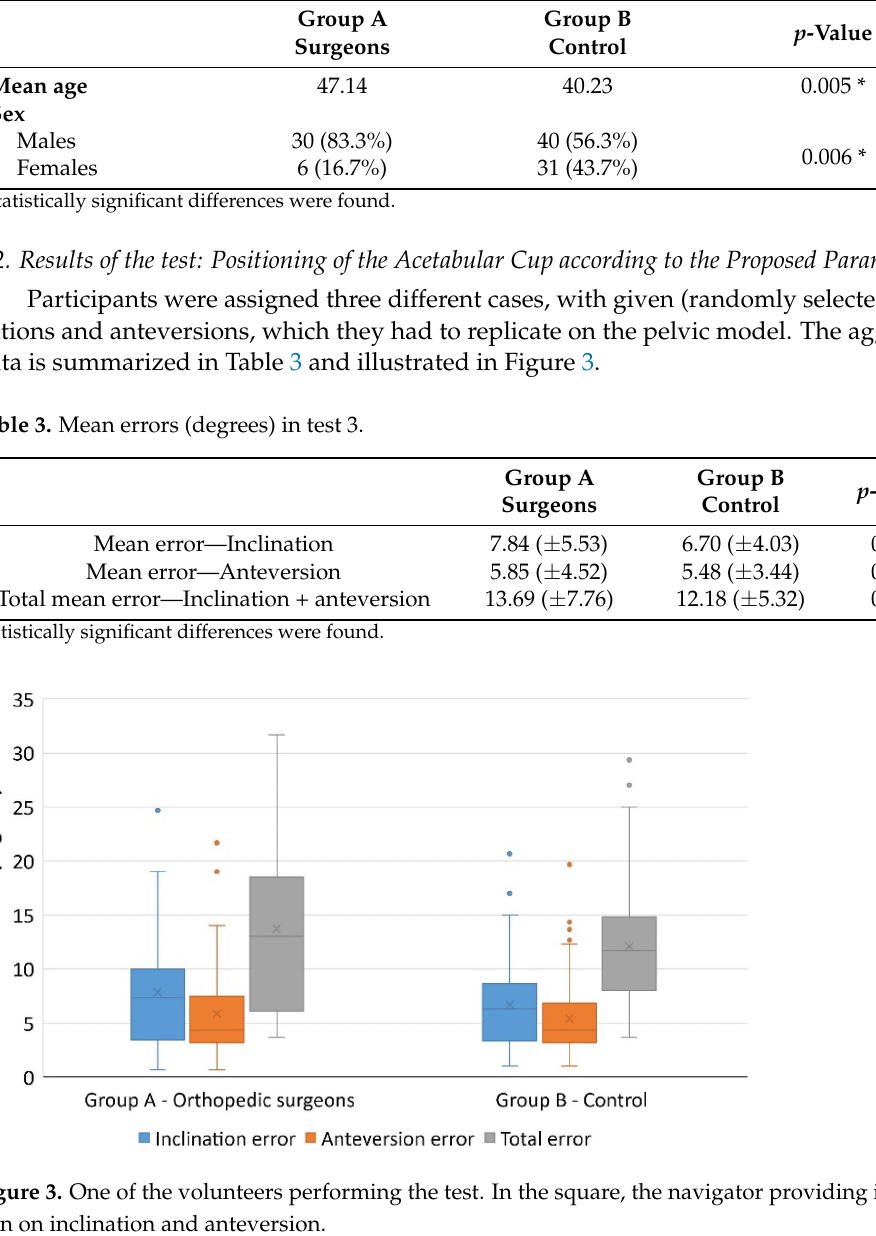
Table 2. Age and sex distribution.